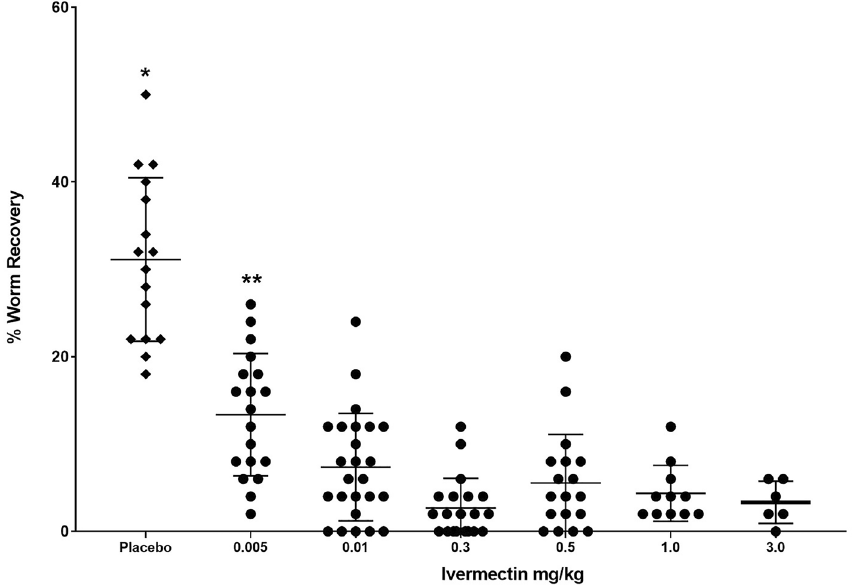
Figure 5. Dose–response curve of ivermectin treatment of NSG mice infected with D. immitis . Mice were infected for 6 weeks with the susceptible MO 2005 isolate of D. immitis and treated on Day 0, 15 and 30 with doses of ivermectin ranging from 0.005 to 3.0 mg/kg. *Statistically significant difference, p value ≤ 0.05 between control and ivermectin-treated groups. **Statistically significant difference, p value ≤ 0.05 between 0.005 mg/kg group recovery and parasite recovery from other ivermectin treated